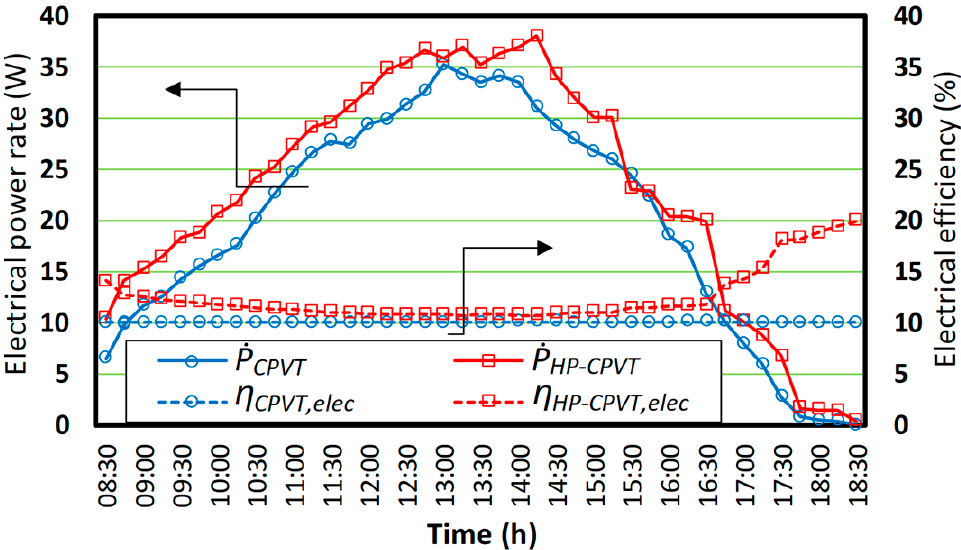
Figure 8. Electric power generated by and electrical efficiency of the bifacial CPVT systems with and without HP.